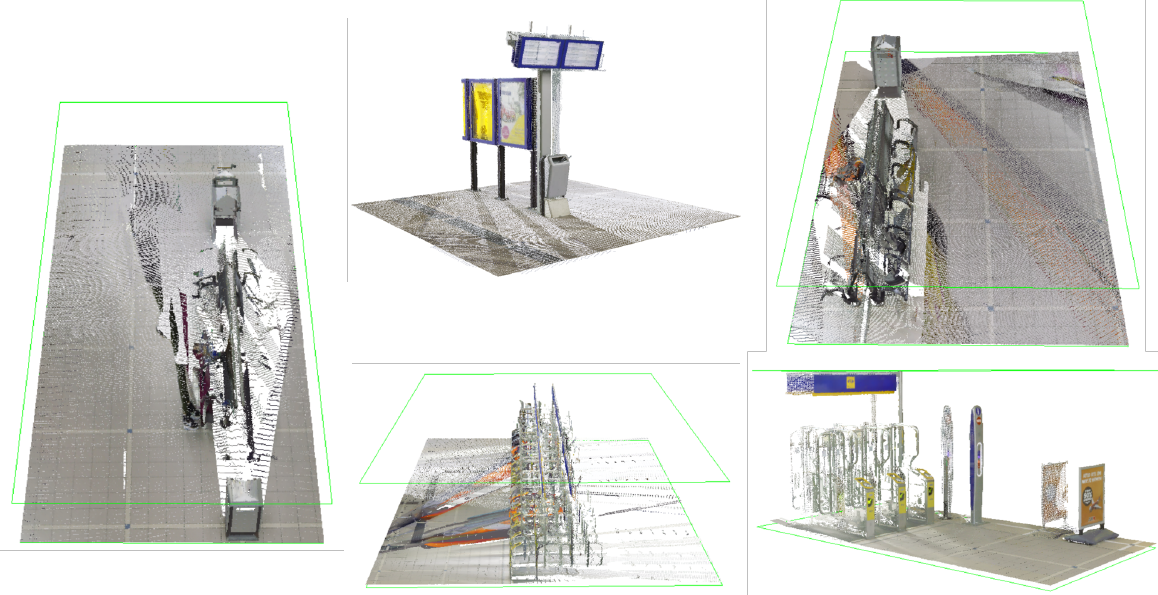
Figure 3. Final data partition to be labelled. Three scenes on the left are used for training, and the rest is for testing.